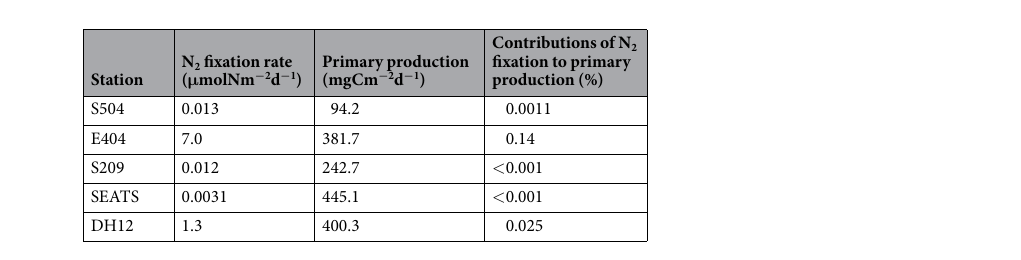
Table 2. Calculated Trichodesmium N 2 fixation rate and its contribution to the primary